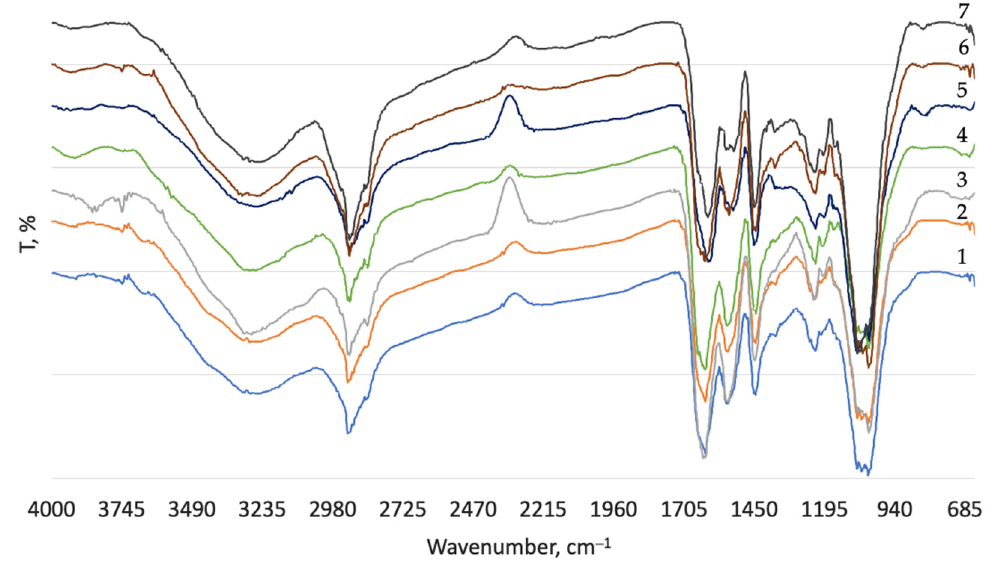
Figure 3. FTIR spectra after post-tanning processes of untreated wet blue (1) and after enzymatic treatment of WB with Zime SB 1% (2); Zime SB 5% (3); Oropon DVP 1% (4); Oropon DVP 5% (5); Oropon WB 1% (6); Oropon WB 5% (7).